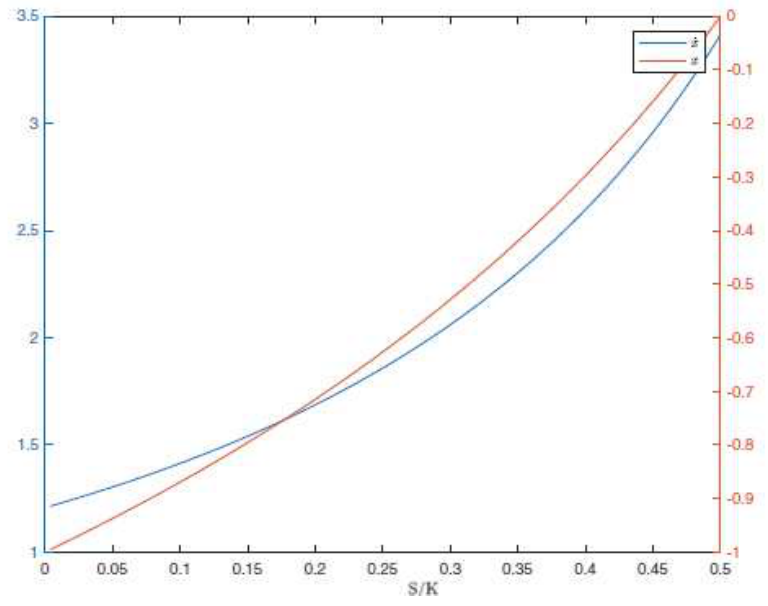
Fig. 6. The mean cost optimal strategy under the Black and Scholes